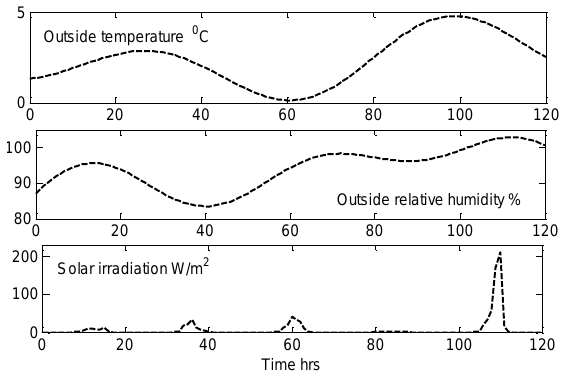
Figure 3: Variation of outside temperature, relative hu- midity and solar irradiation during the exper- imental period.